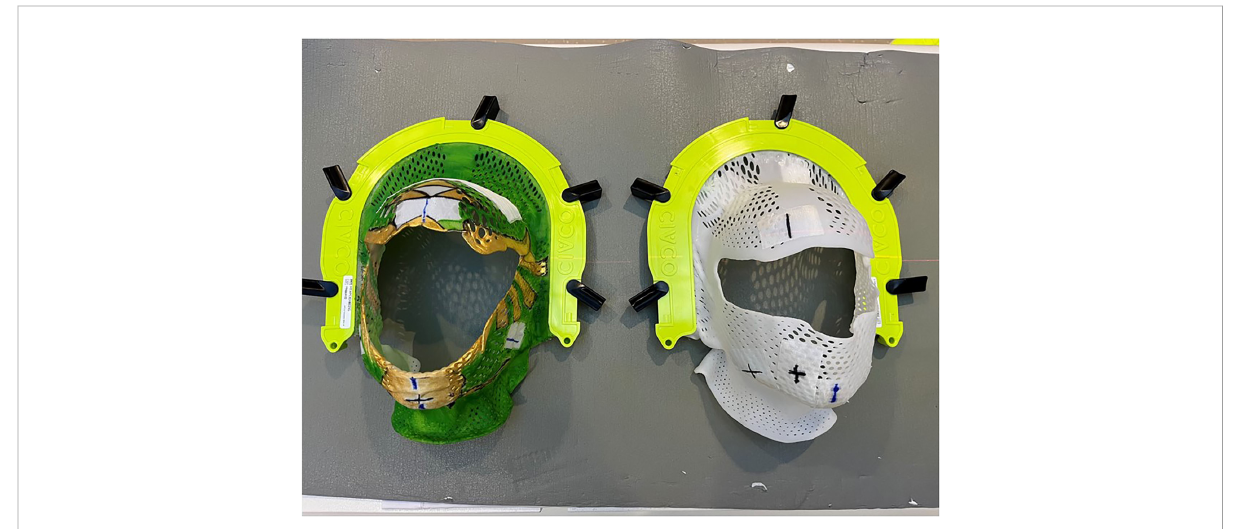
FIGURE 6 This image illustrates a mask used to treat a pediatric patient for metastatic neuroblastoma that has been decorated with paint that contained metallic components. All devices used during MRgRT must be MR compatible. In this case, the patient was re-simulated before treatment with an unpainted